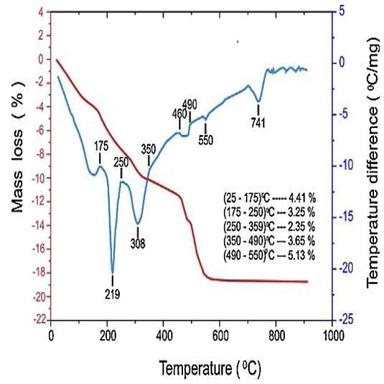
DTA Curve of the tailing waste material from Veliko Rudare Deposit.